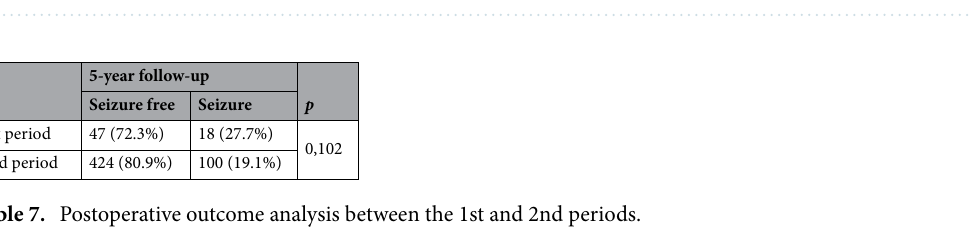
Figure 3. Comparison between the hazard ratio (95% CI) of each variable (1st period vs. 2nd period).